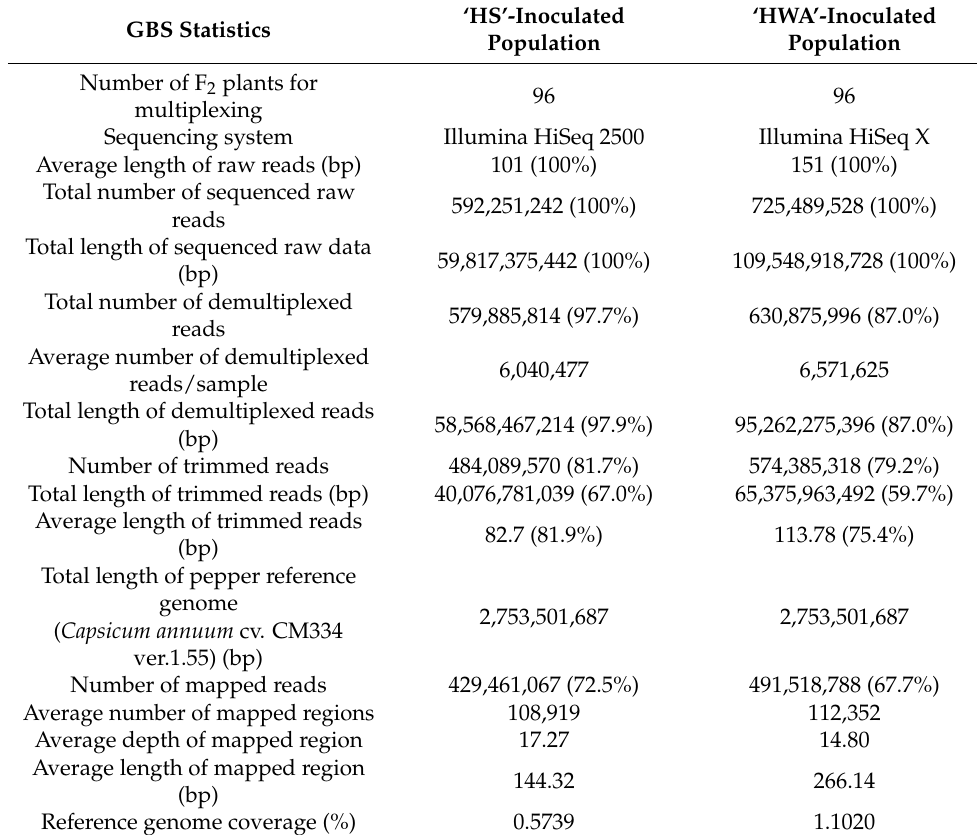
Table 2. Summary of sequence data generated by genotyping-by-sequencing analysis using two F 2 populations of ‘Konesian Hot’ inoculated with a moderately pathogenic ‘HS’ isolate and a highly pathogenic ‘HWA’ isolate of Ralstonia solanacearum . ‘HS’-Inoculated ‘HWA’-Inoculated GBS Statistics Population Population Number of F 2 plants for 96 96 multiplexing Sequencing system Illumina HiSeq 2500 Illumina HiSeq